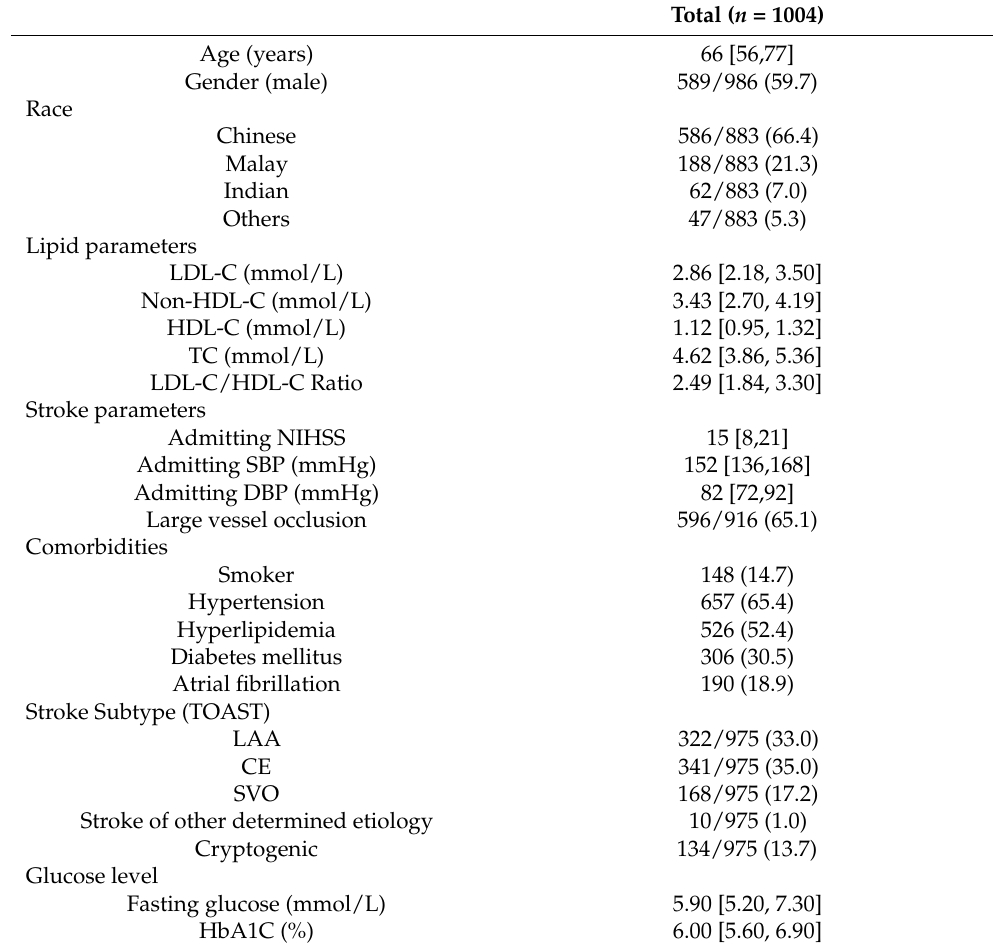
Table 1. Baseline Characteristics of Study